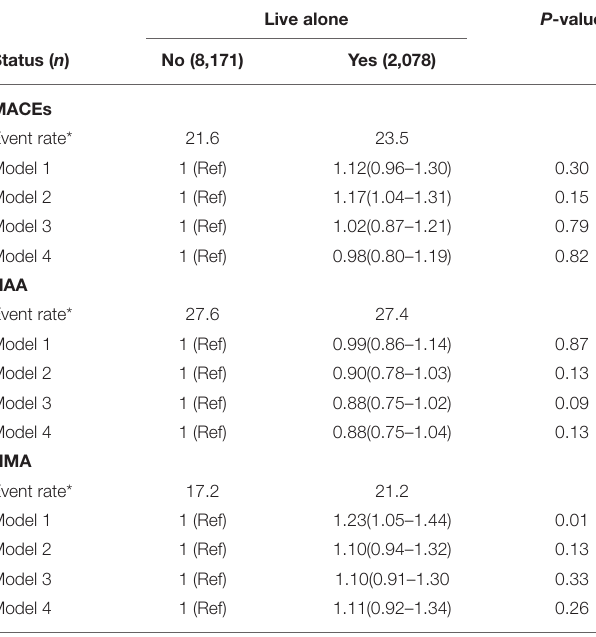
TABLE 2 | Association between living alone and risk of HAA, HMA, and